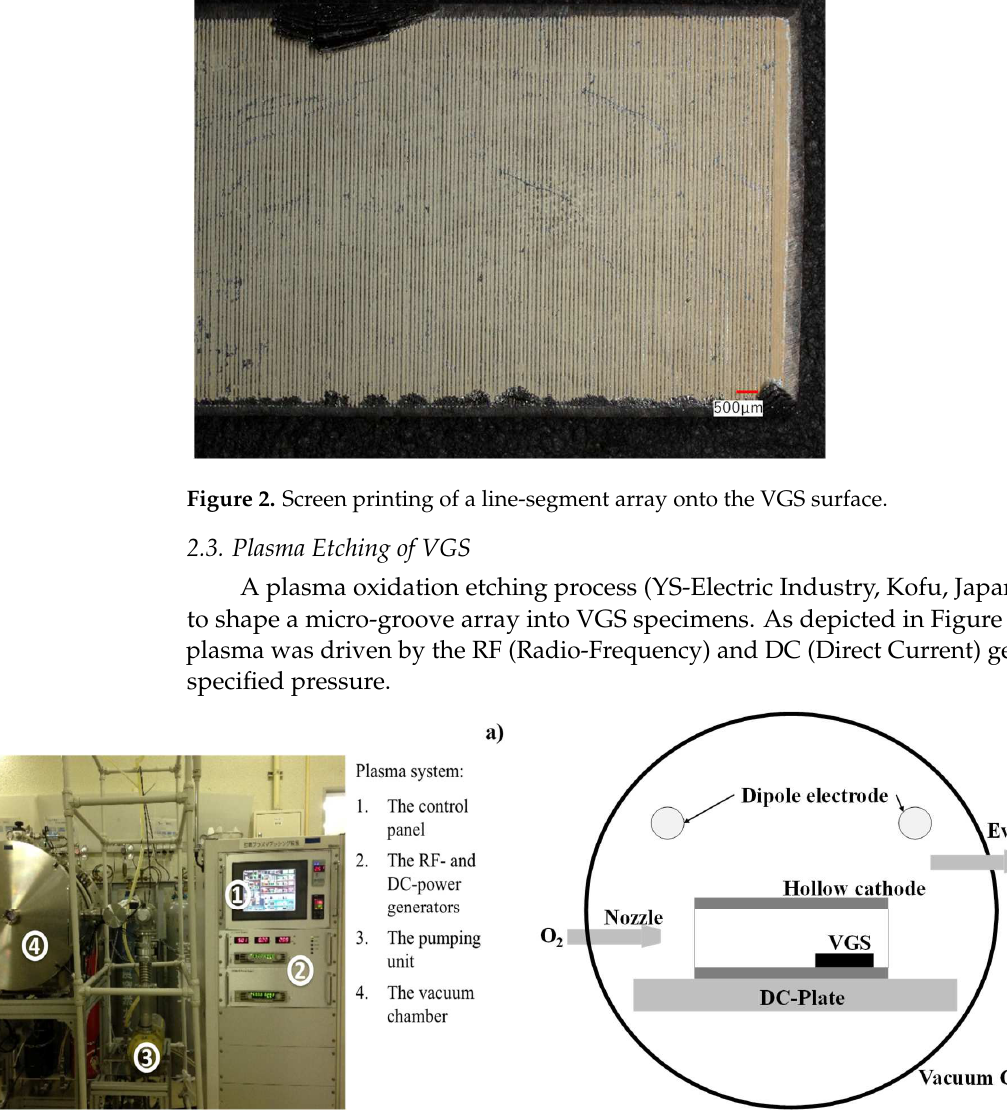
Figure 3. Plasma etching system for micro texturing into the graphene substrate. ( a ) Overall view of the etching system, and ( b ) schematic view of the experimental setup for etching.